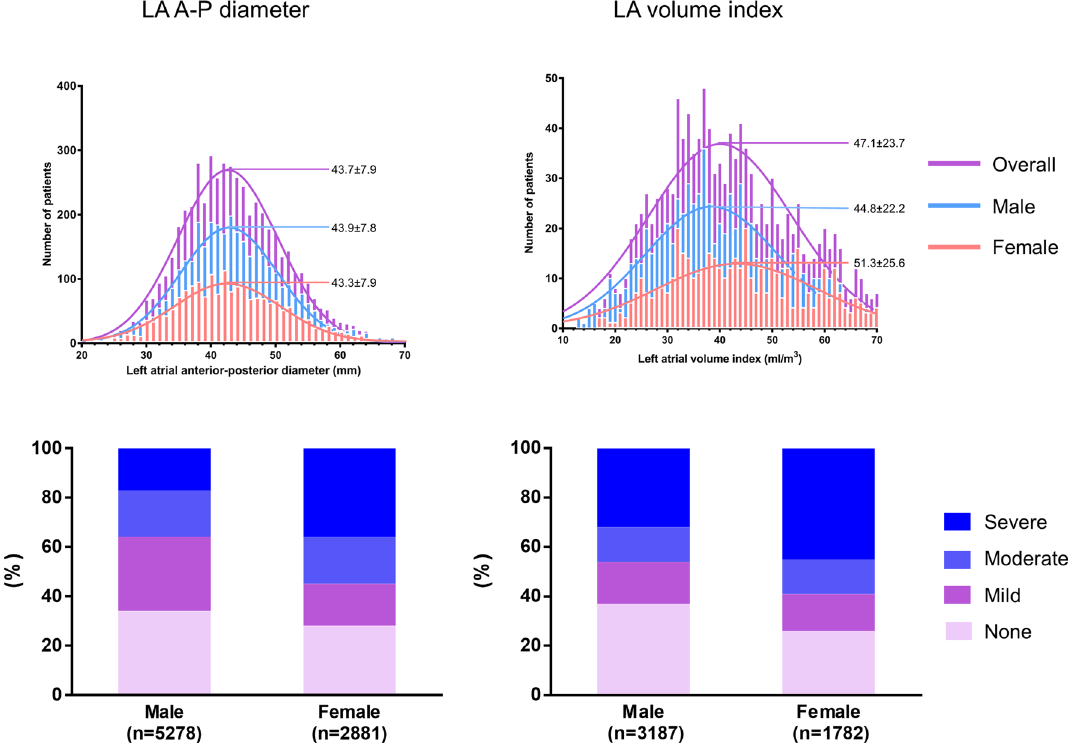
Figure 2. Distribution of left atrial size by left atrial anterior–posterior diameter (left) and left atrial volume index (right) in the overall population.